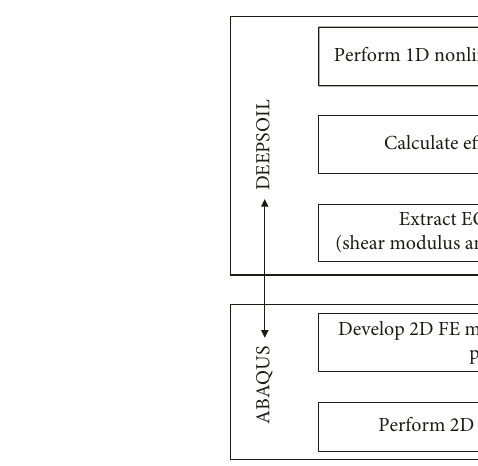
Figure 2: EQL history analysis procedure.